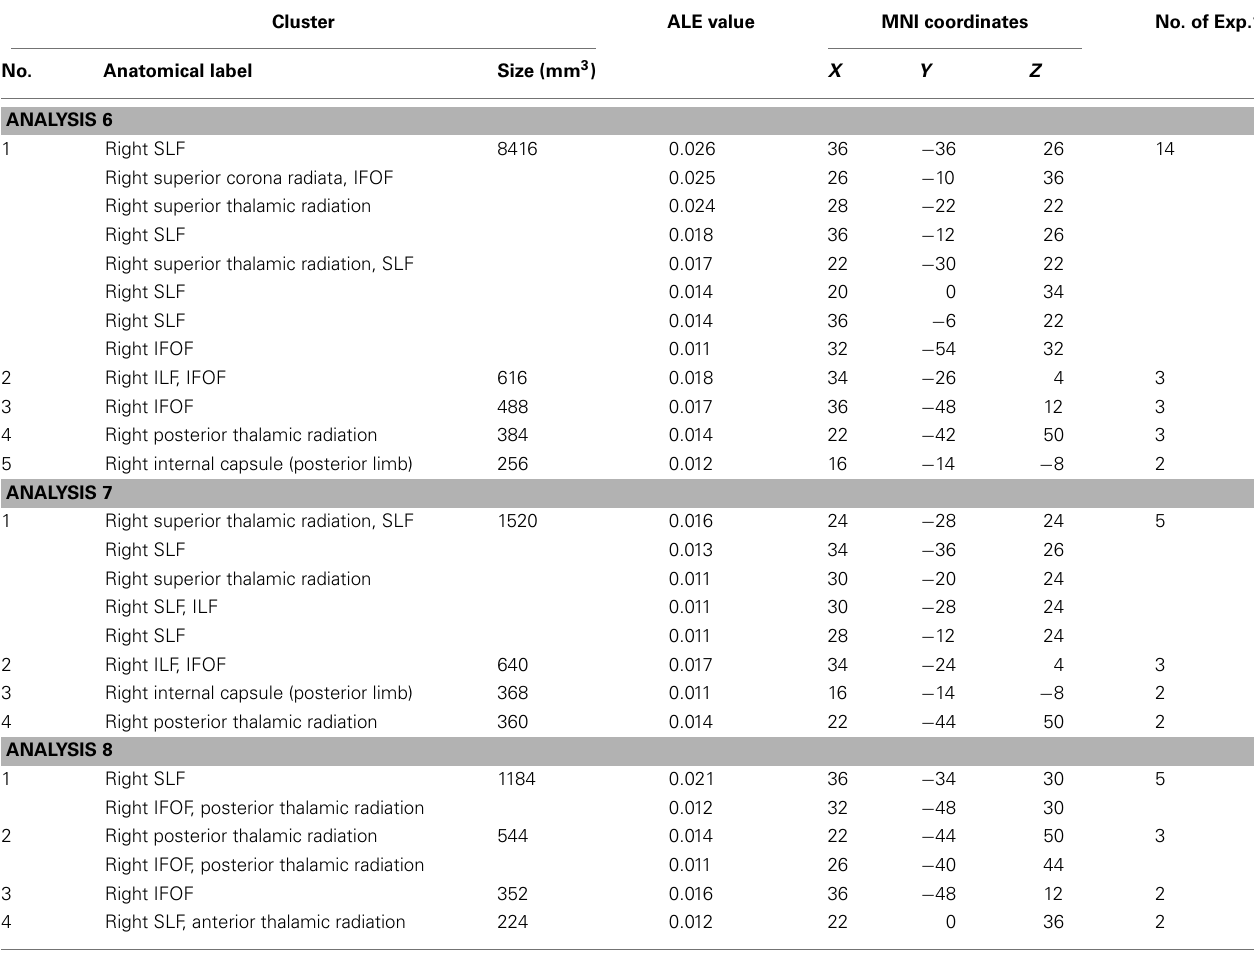
Table 4 | SignificantALE clusters located within white matter and corresponding MNI coordinates identified inAnalyses 6, 7, and